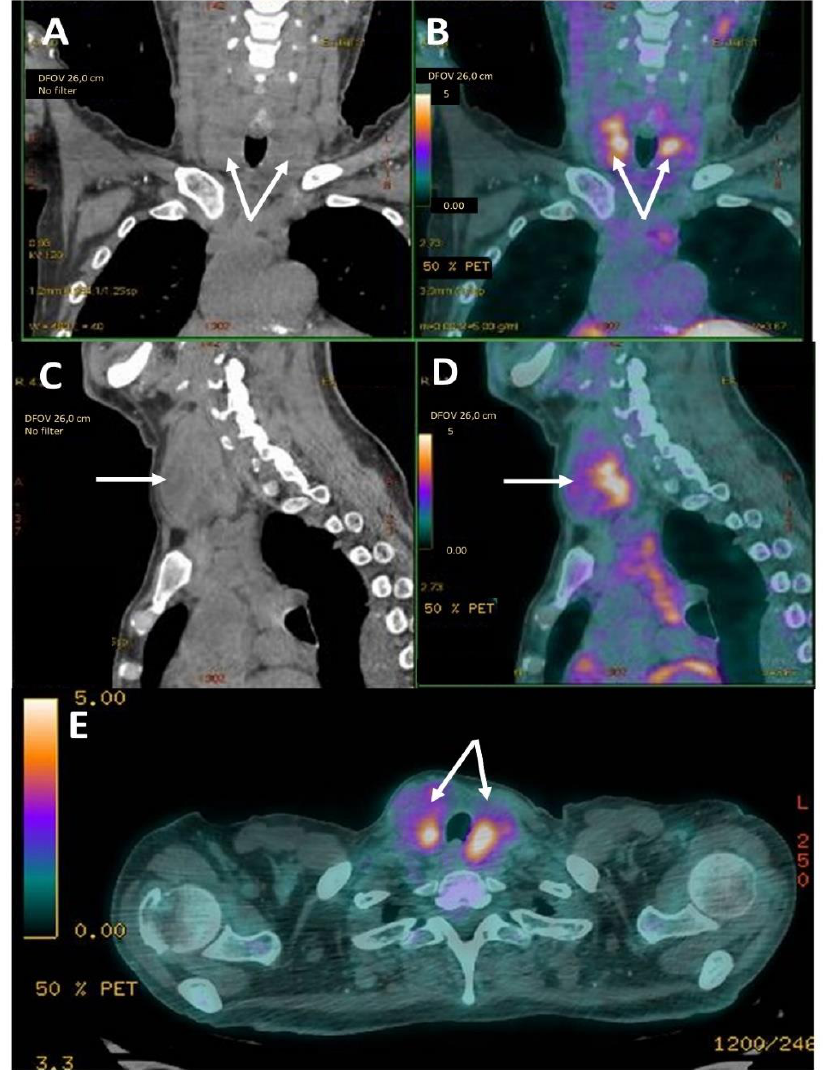
Figure 3. FDG 18 -PET hypermetabolic goiter. ( A , B ) Front section of CT, ( C , D ) sagittal section and ( E ) axial section of computerized tomography and FDG 18 -PET from patient B, showing enlargement and hypermetabolism of both lobes of thyroid gland (white arrows).